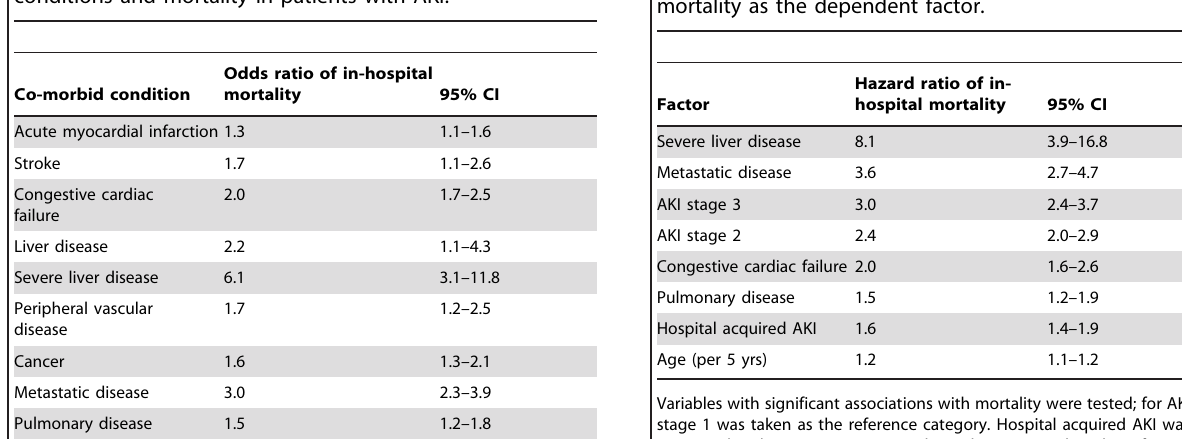
Table 3. Univariate associations between co-morbid conditions and mortality in patients with AKI.